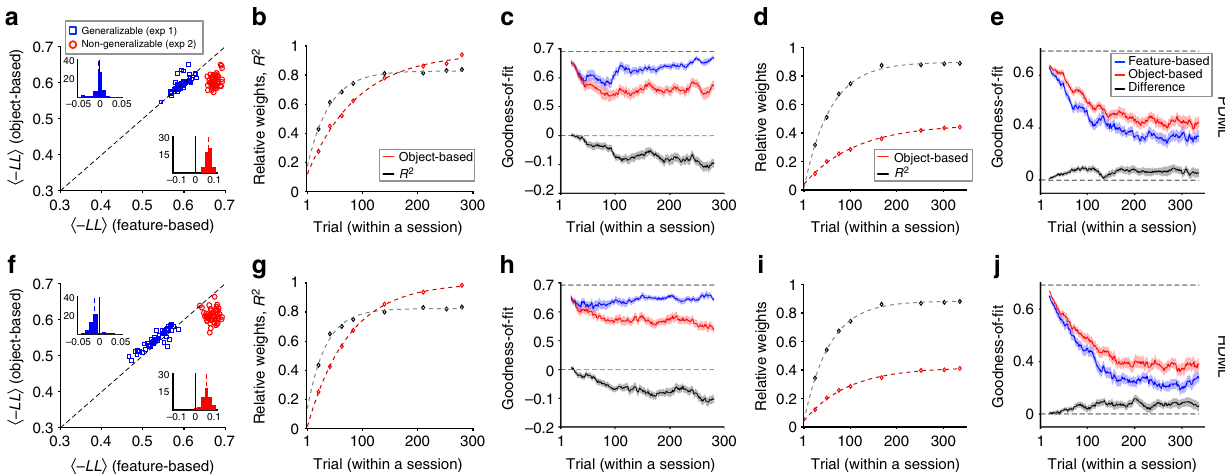
Fig. 7 Replicating the pattern of experimental data using the PDML and HDML models. a Comparison of the goodness-of- fi t in for the data generated by the PDML model in Experiments 1 (generalizable) and 2 (non-generalizable) using the object-based and feature-based RL models with decays. The insets show histograms of the difference in the negative log likelihood (- LL ) based on the fi ts of the two models. In contrast to the experimental data, choice behavior of the PDML model in Experiment 1 was equally fi t by the object-based and feature-based models. b The time course of model adoption in the PDML model. Plotted is the relative weight of object-based to the sum of the object-based and feature-based weights, and explained variance in estimates ( R 2 ) over time in Experiment 3. Dotted lines show the fi t of data based on an exponential function. c Transition from feature-based to object-based learning in the PDML model. Plotted are the average negative log likelihood based on the best feature-based model, best object-based RL model, and the difference between object-based and feature-based models in Experiment 3. Shaded areas indicate s.e.m., and the dashed line shows the measure for chance prediction. d , e The same as in b , c , but for simulations of Experiment 4. f – j The same as in a – e , but for the HDML model. Although both models qualitatively replicated the pattern of experimental data in Experiments 2 – 4, only the behavior of HDML model was consistent with data in Experiment